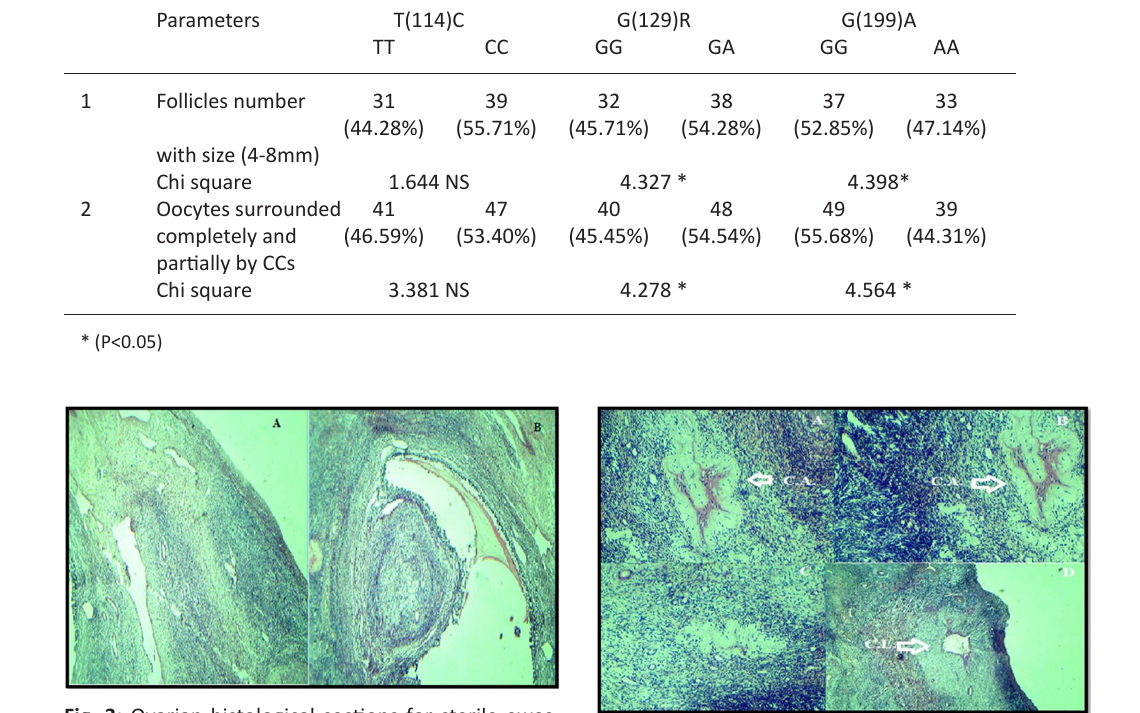
Fig. 3: Ovarian histological sections for sterile ewes. (A) hypoplatic ovarian tissue, (B) follicular cells degeneration (H&E X40).